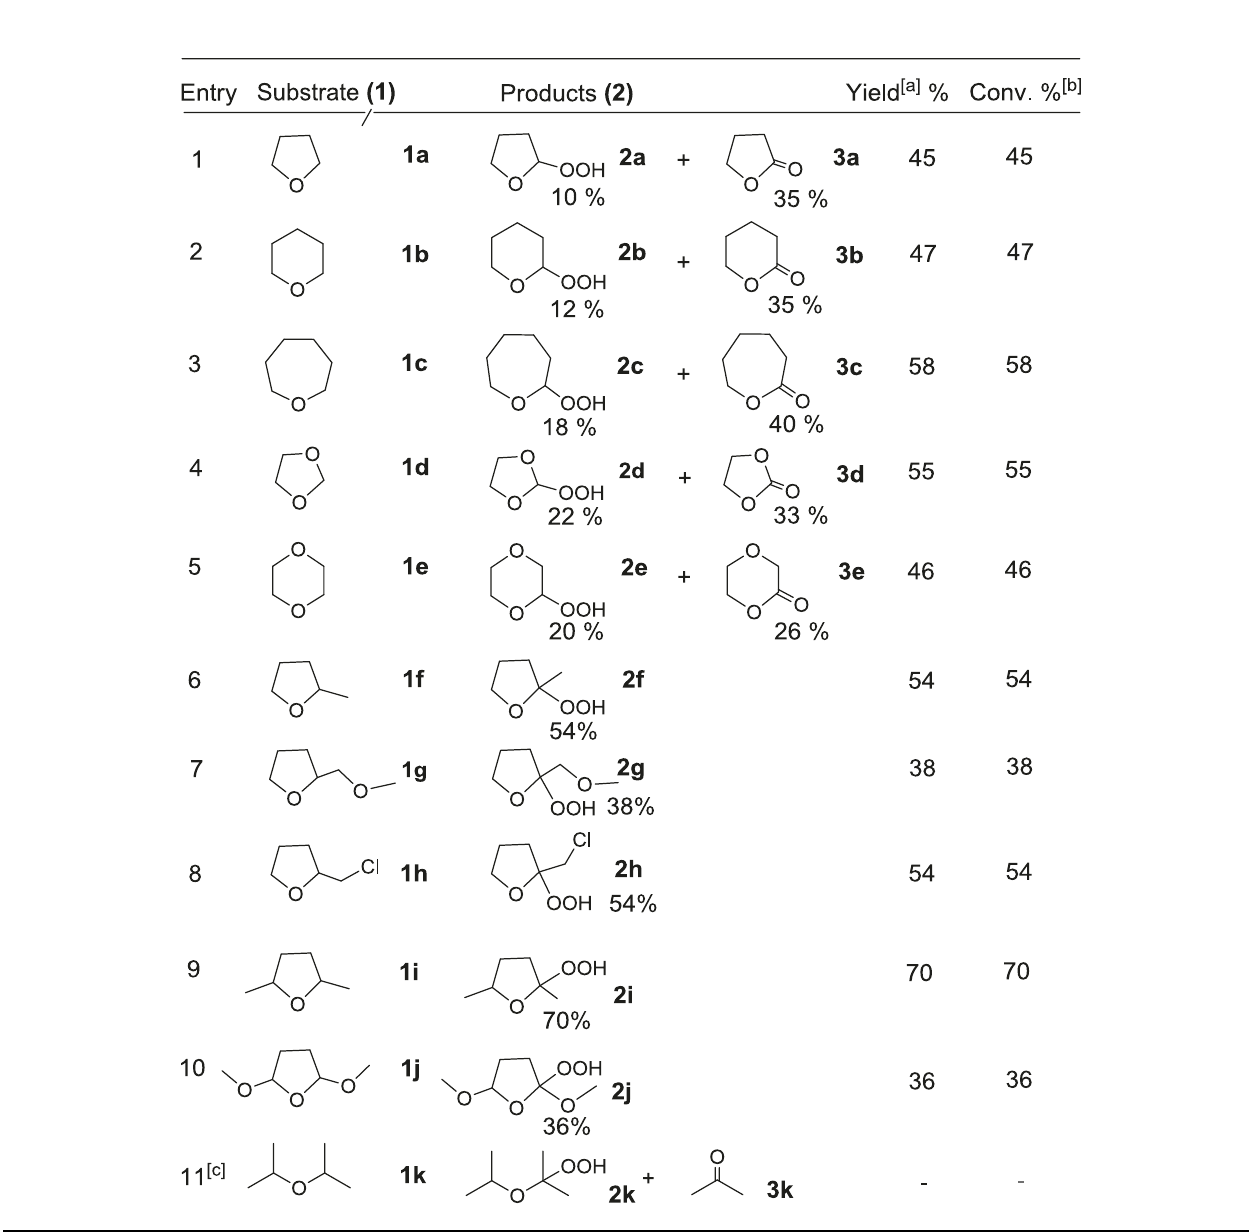
Table 1 Substrate scope of aliphatic